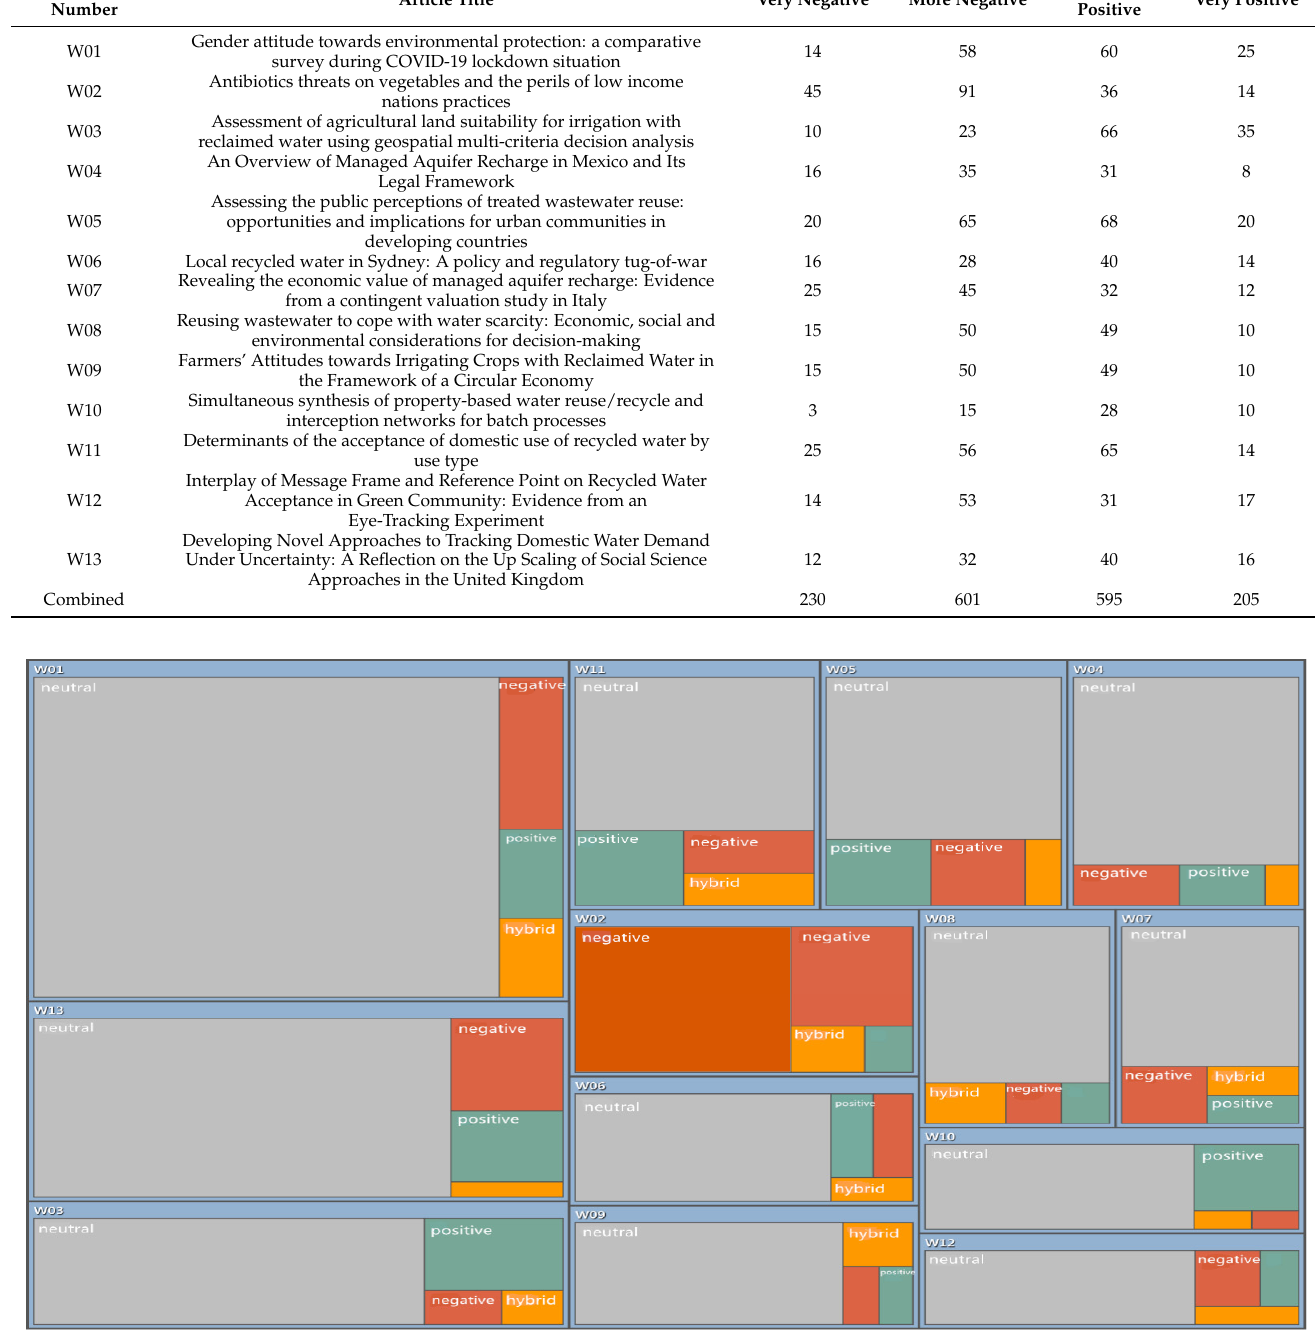
Figure 19. Hierarchical summary of automatically coded emotions toward highly cited literature in WOS. Table 11. Summary of results of sentiment analysis of highly cited literature in WOS.